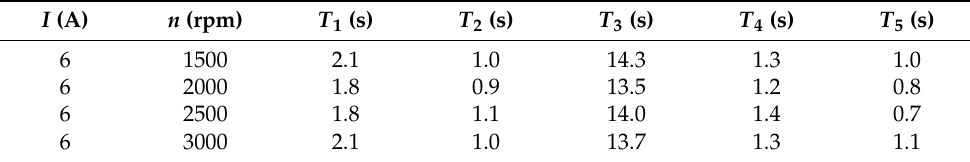
Table 6. Control time of the clearance control actuator at different rotational speeds.